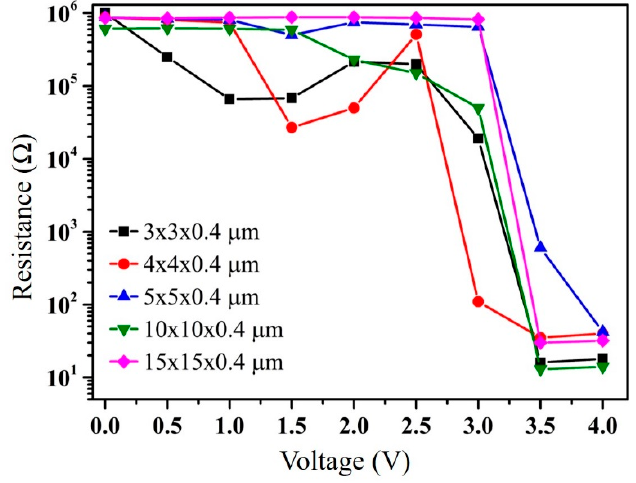
Figure 6. Effect of cross-sectional area on Joule heating-induced crystallization in GeTe vertical resistors (same inter-electrode distance).